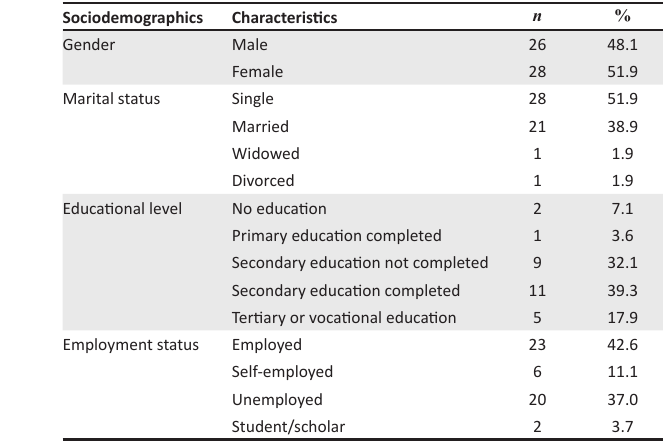
TABLE 1: Sociodemographic characteristics of lost to follow-up patients.